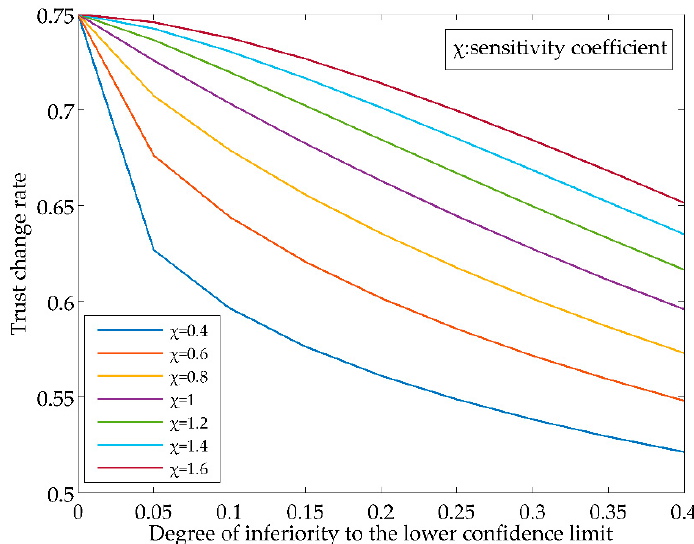
Figure 3. The influence of sensitivity coefficient on trust reduction. Step 4. Sorting of the alternatives.